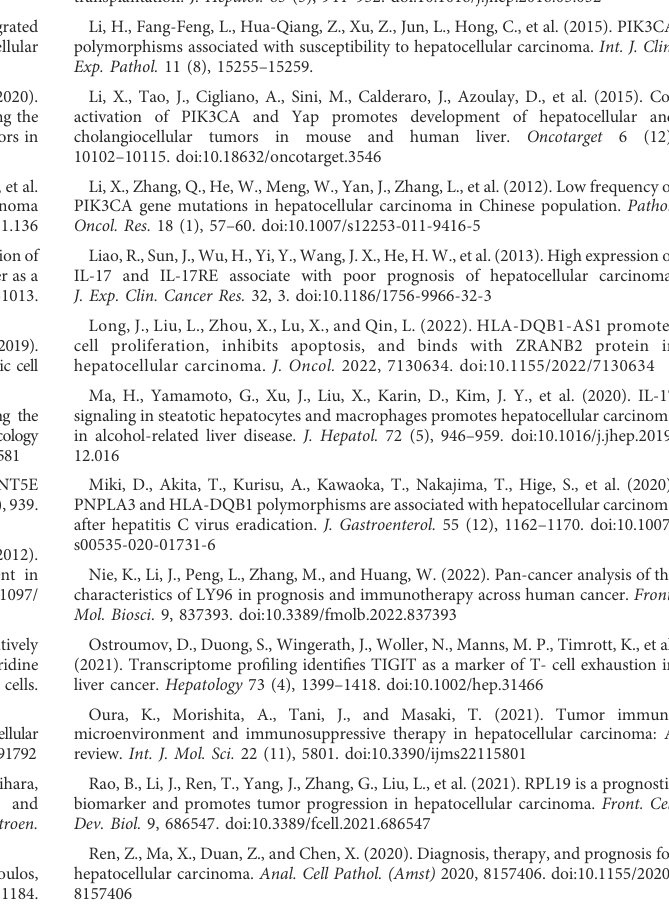
SUPPLEMENTARY FIGURE S1 Correlation analysis of ICD associated DEGs and different immune cells. (A) CASP8, (B) BAX, (C) LY96, (D) ENTPD1, (E) CXCR3, (F) HSP90AA1, (G) CALR, (H) PDIA3, (I) IL6, (J) CD4; ICD: Immunogenic cell death, DEGs: Differentially expressed genes).